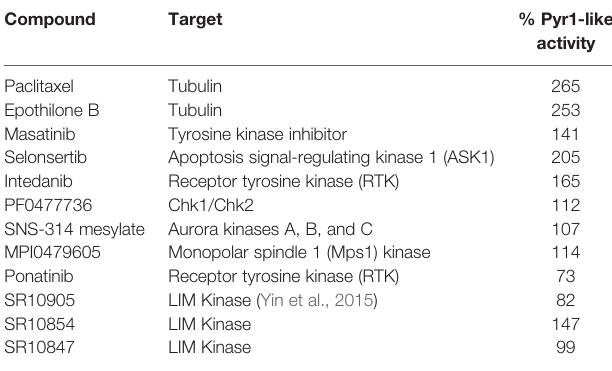
TABLE 1 | Hits selected by